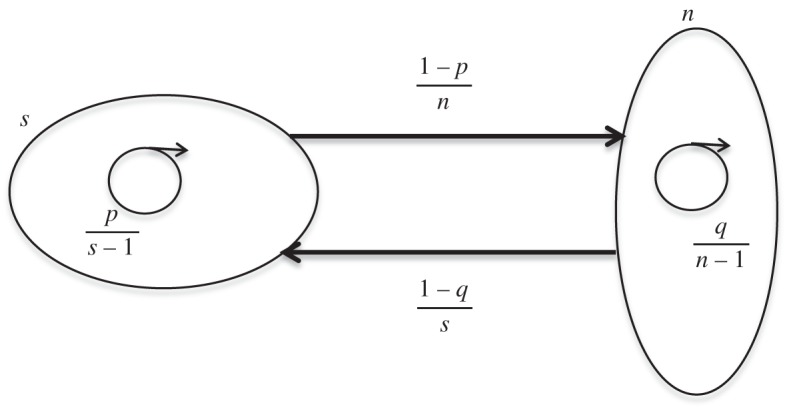
Schematic of a partial bipartite graph.